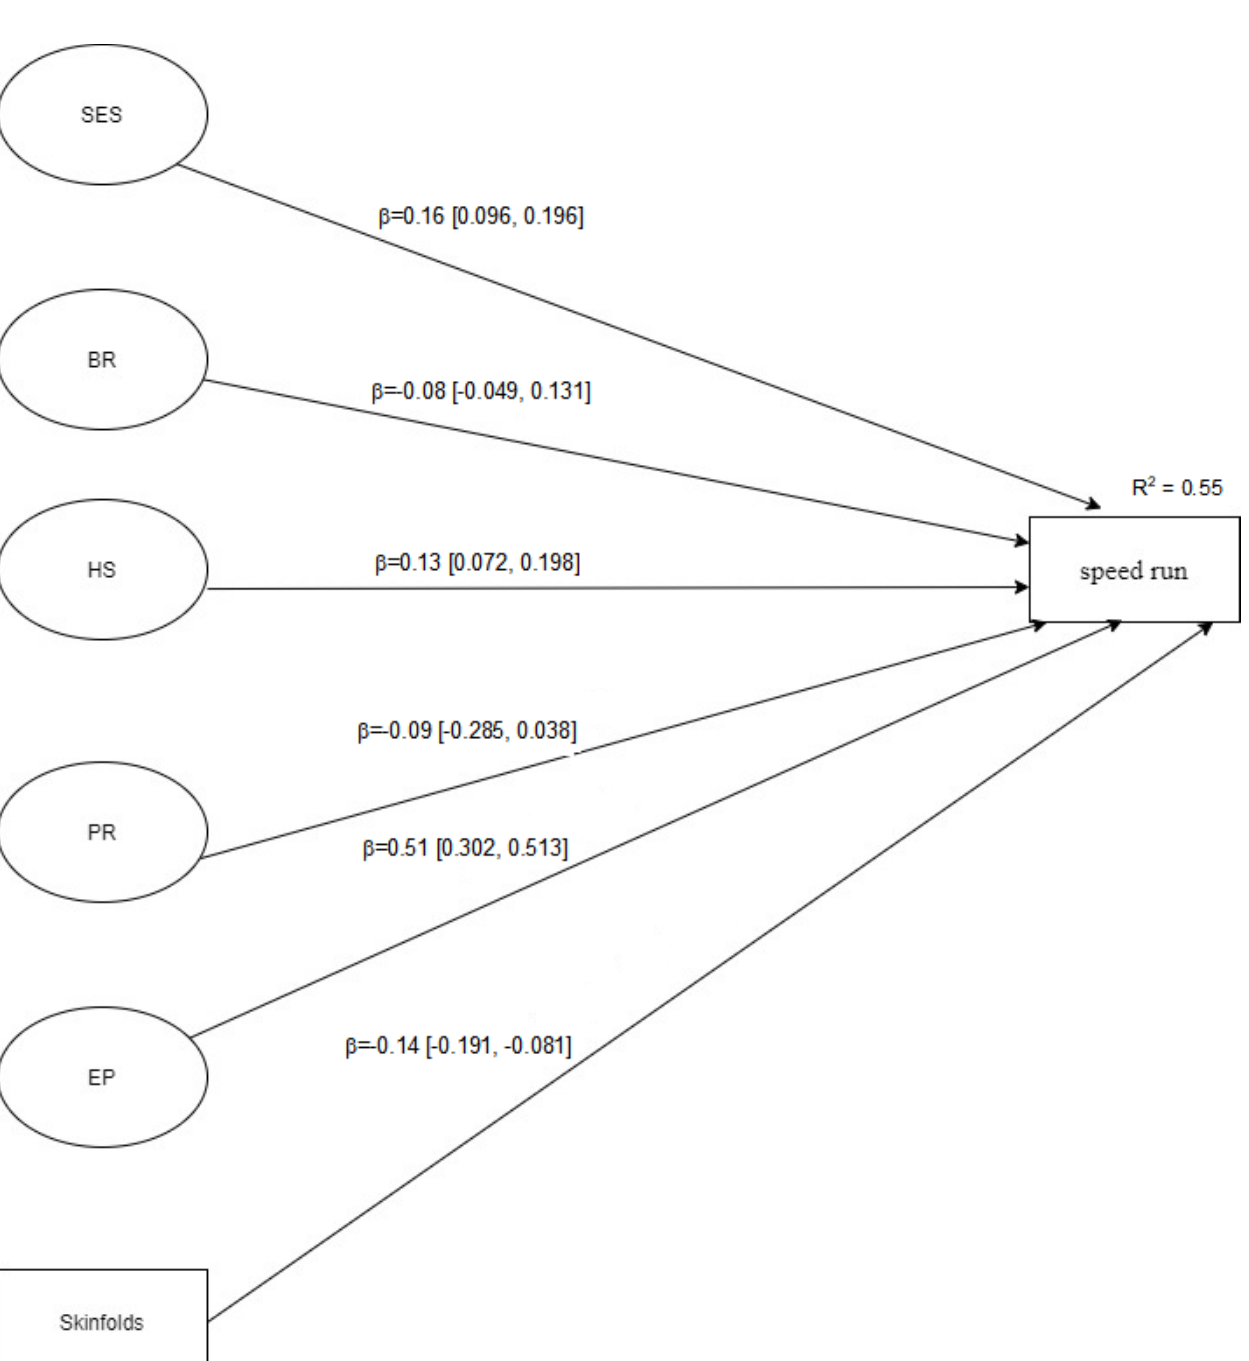
Figure 3. Structural model for speed run. Note. SES = socio-economic status; BR = brotherhood relationship; HS = house space; PR = peer relationships; EP = educational practice; skinfolds = sum of 5 different skinfolds, including bi-acromial breadth, hip breadth, upper arm girth, standing calf girth, and upper limb length.